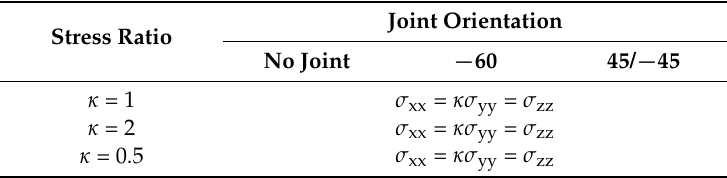
Figure 19. Sketch of model geometry and boundary conditions. Table 5. Parameters for rock mass. Table 6. Stress and joint constellations for tunnel model.